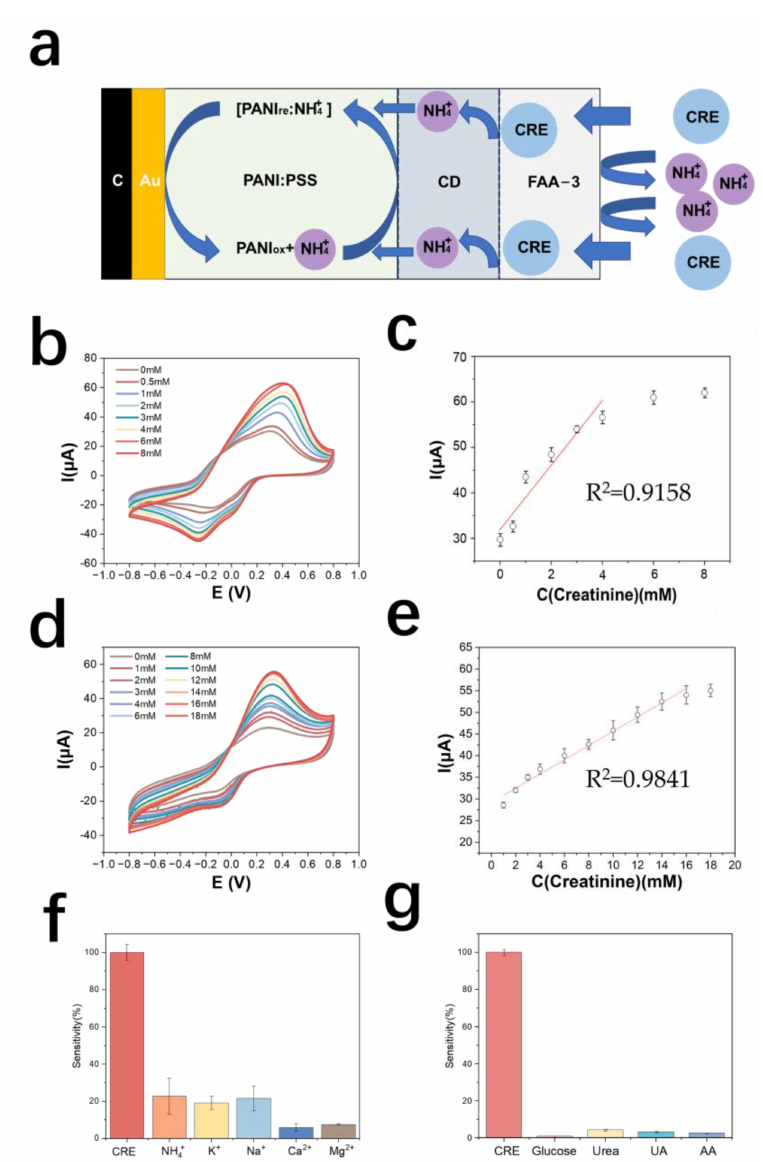
Figure 5. ( a ) Schematic diagram of the detection principle of PANI: PSS-creatinine-deiminase-based creatinine electrode; ( b ) cyclic voltammetric curves of creatinine electrodes in urea solutions of dif- ferent concentrations; ( c ) calibration curves of creatinine electrodes; ( d ) response curves of chitosan- modified creatinine electrodes for different concentrations of creatinine; ( e ) calibration curves of chitosan-modified creatinine electrodes for different concentrations of creatinine; ( f ) creatinine elec- trode resistance to cations (In 0.01 M PBS solution, 2 mM creatinine, 5 mM NH 4 Cl, 5 mM KCl, 5 mM NaCl, 5 mM CaCl 2 , and 5 mM MgCl 2 were sequentially added); ( g ) creatinine electrode resistance to metabolites (In a 0.01 M PBS solution, sequentially add into the solution containing the interfering metabolites, including 50 µ M glucose, 10 mM urea, 50 µ M UA, and 100 µ M